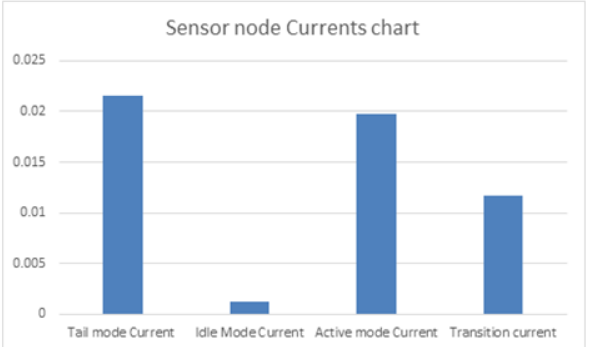
Figure 12. Current consumption in different modes.